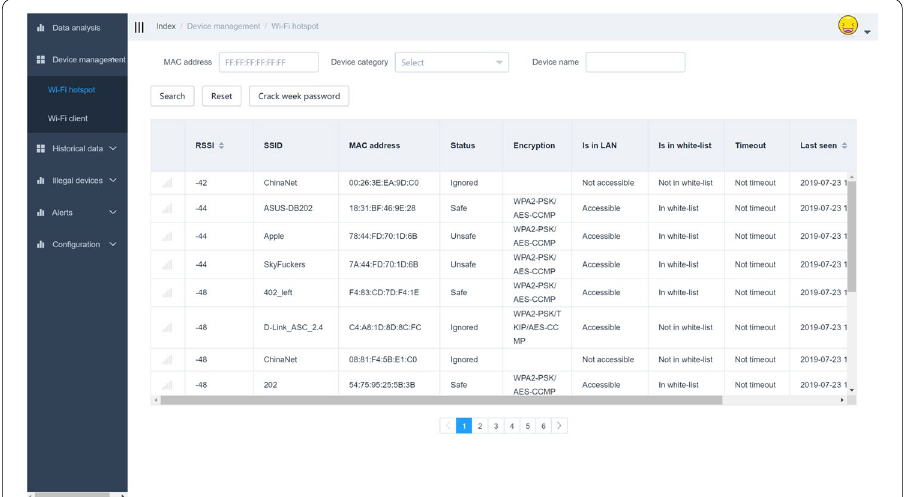
Fig. 7 User interface of the